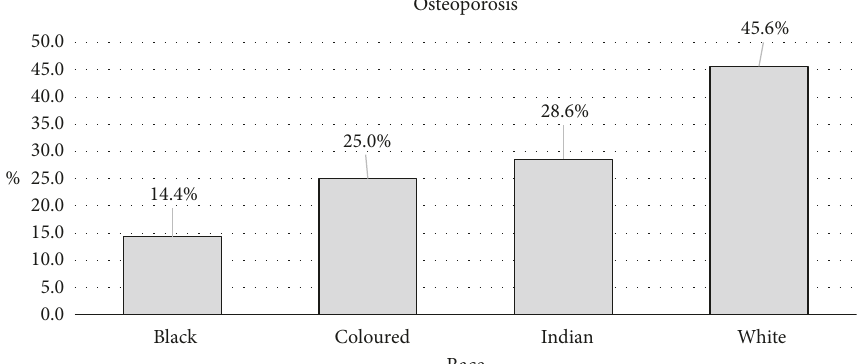
Figure 3: Proportion of patients by racial group, diagnosed with osteoporosis identified from opportunistic CT scans of men at Kalafong Hospital, Tshwane, South